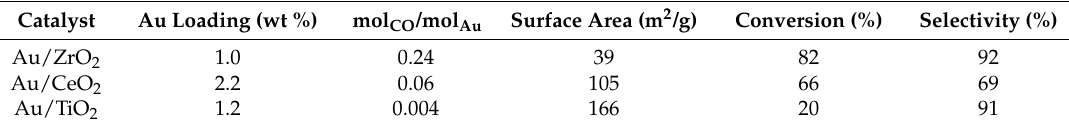
Table 4. Physicochemical properties and catalytic performances of the